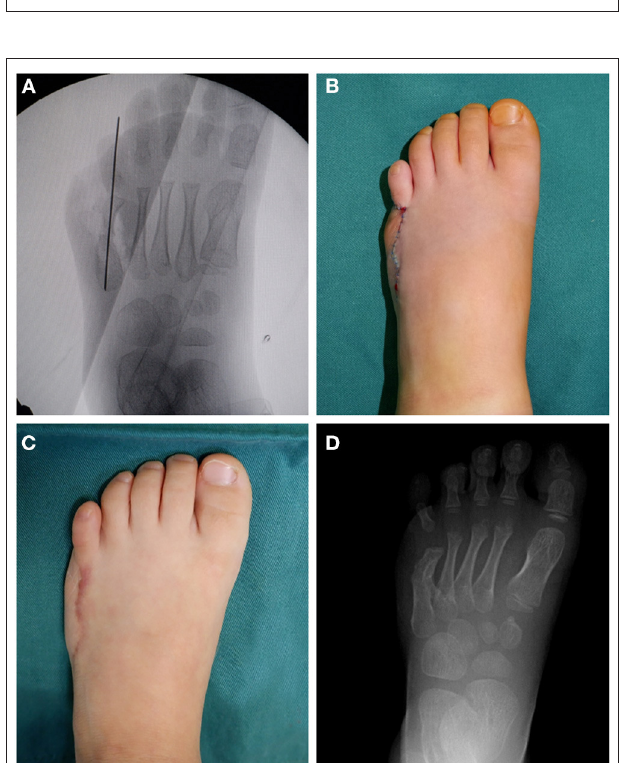
FIGURE 3 | Intraoperative fluoroscopic images, immediate postoperative appearance and 1-year follow-up findings. (A) Intraoperative fluoroscopic radiographic images showing the fifth ray axis was restored and the wide forefoot was improved. (B) Immediate postoperative photos showing the appearance of the foot. (C) Photos showing the appearance of the operated foot at 1-year after surgery. (D) Radiograph showing good healing ang the fifth ray axis was restored, taken 1-year after